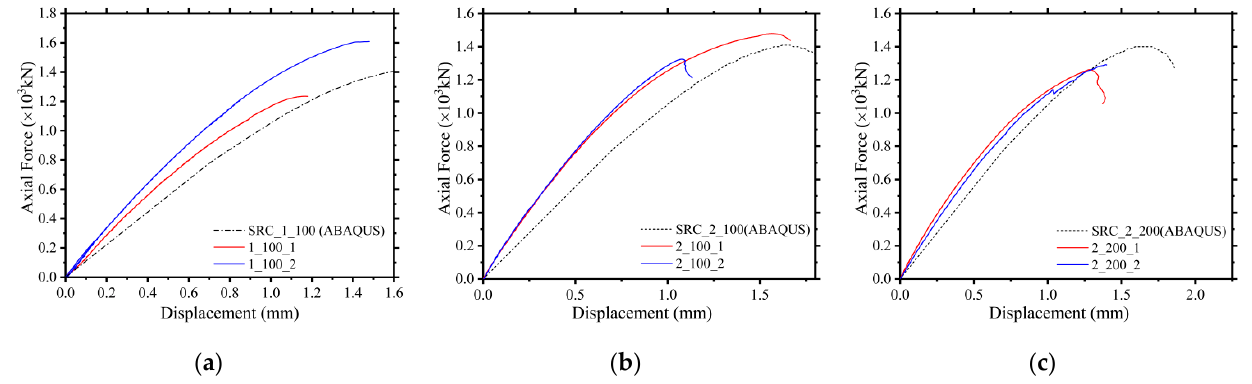
Figure 3. Comparison of F-D curves of some test columns and finite element model: ( a ) F-D curve of 1-100; ( b ) F-D curve of 2-100; ( c ) F-D curve of 2-200.